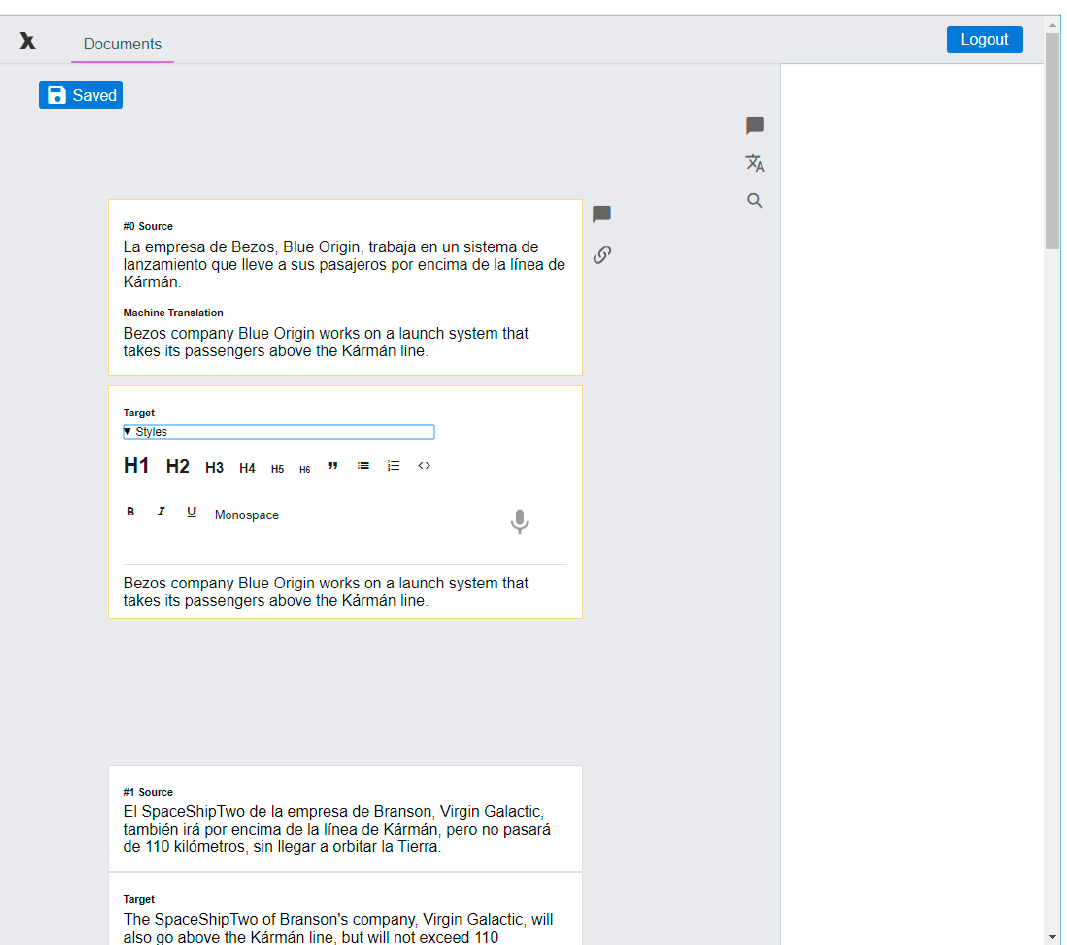
Figure 1. Interface of our initial prototype showing the basic Edit view.